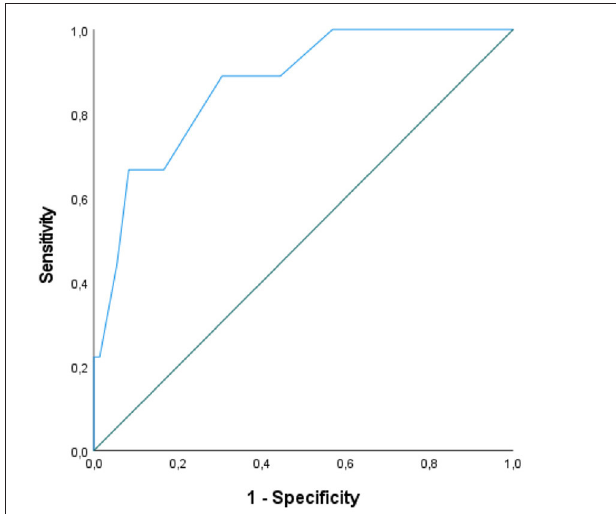
FIGURE 1 | ROC curve for ADI-12 scores as tested against the HADS-D. ROC, receiver-operating characteristic; ADI-12, ALS Depression Inventory-12; HADS-D, Hospital Anxiety and Depression Scale-Depression. A HADS-D ≥ 10 was addressed as indexing depression. 88.9% of sensitivity and 69.4% of specificity at a cut-off of 27.5 (AUC = 0.87; SE = 0.06; 95% CI [0.75,